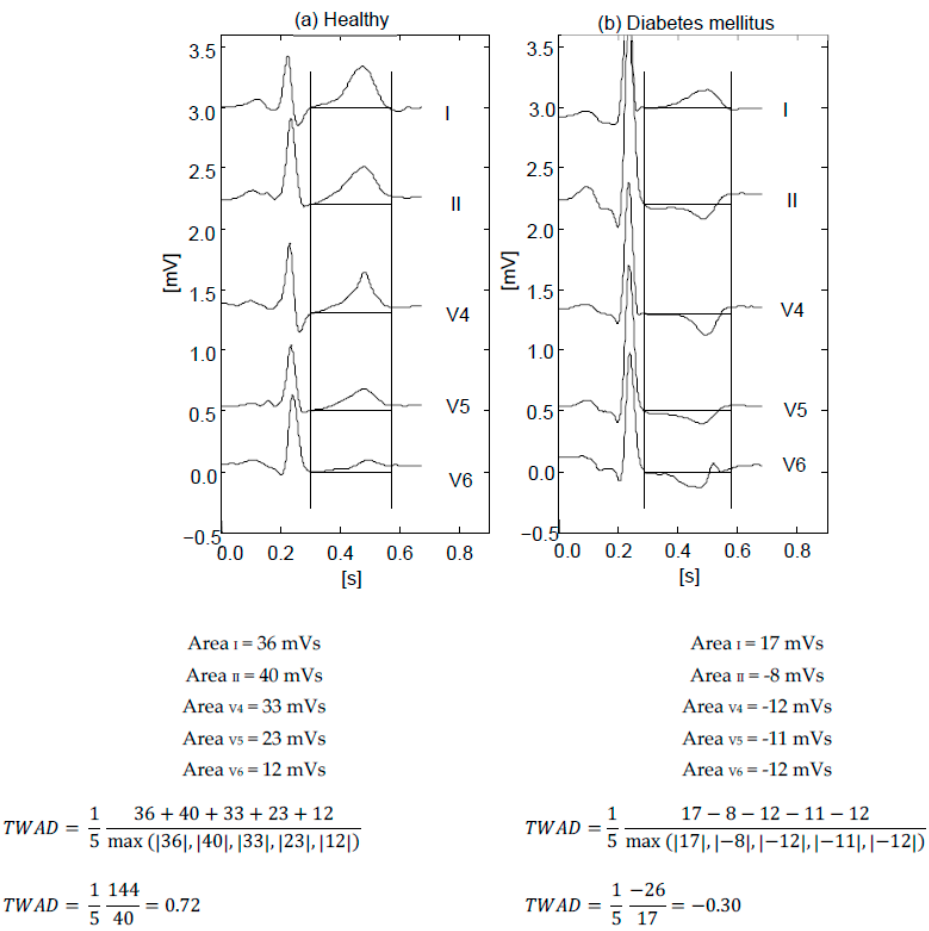
Figure 1. TWAD in a healthy patient ( a ) and in a patient with diabetes mellitus ( b